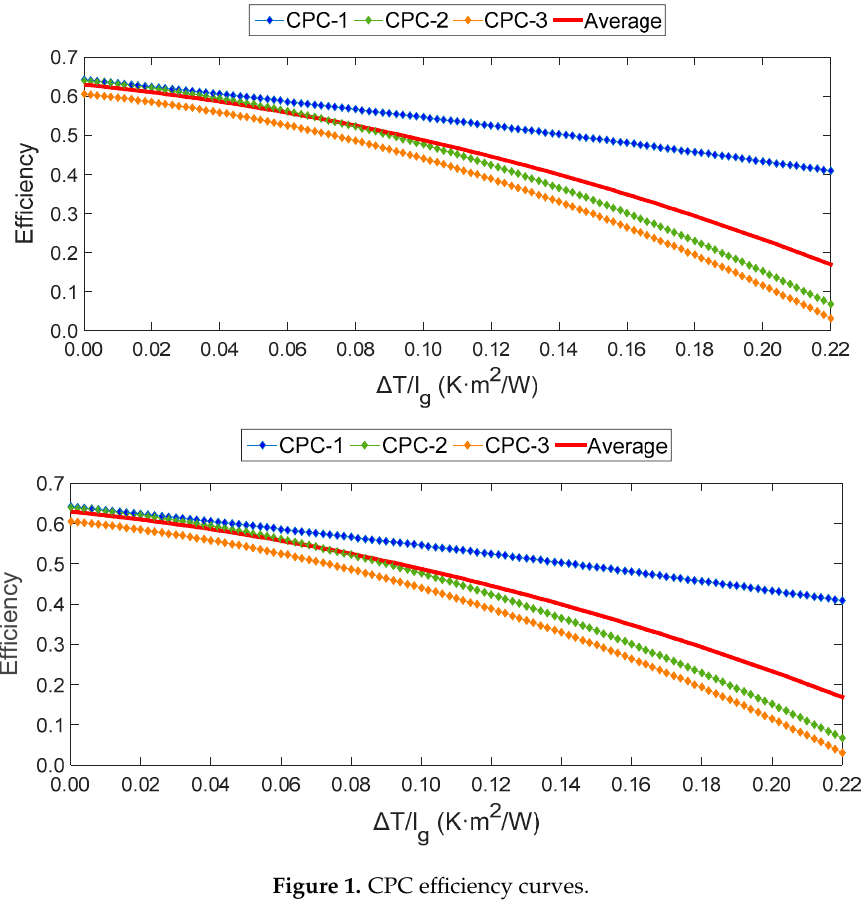
Figure 1. CPC efficiency curves. Table 3. Incident angle modifier